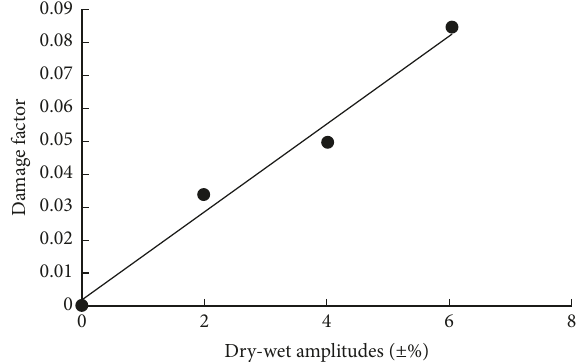
Figure 9: Variation of damage factor with the dry-wet